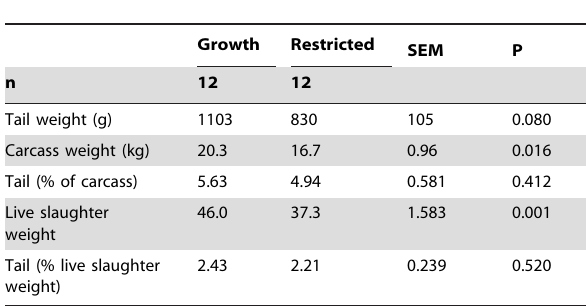
Table 1. Effect of feed restriction on the growth and fat tail in Damara ram